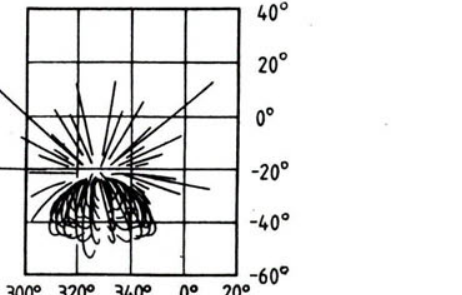
Fig. 10. Coronal magnetic field of an active region approximated by the field of dipols in the cylindrical system of